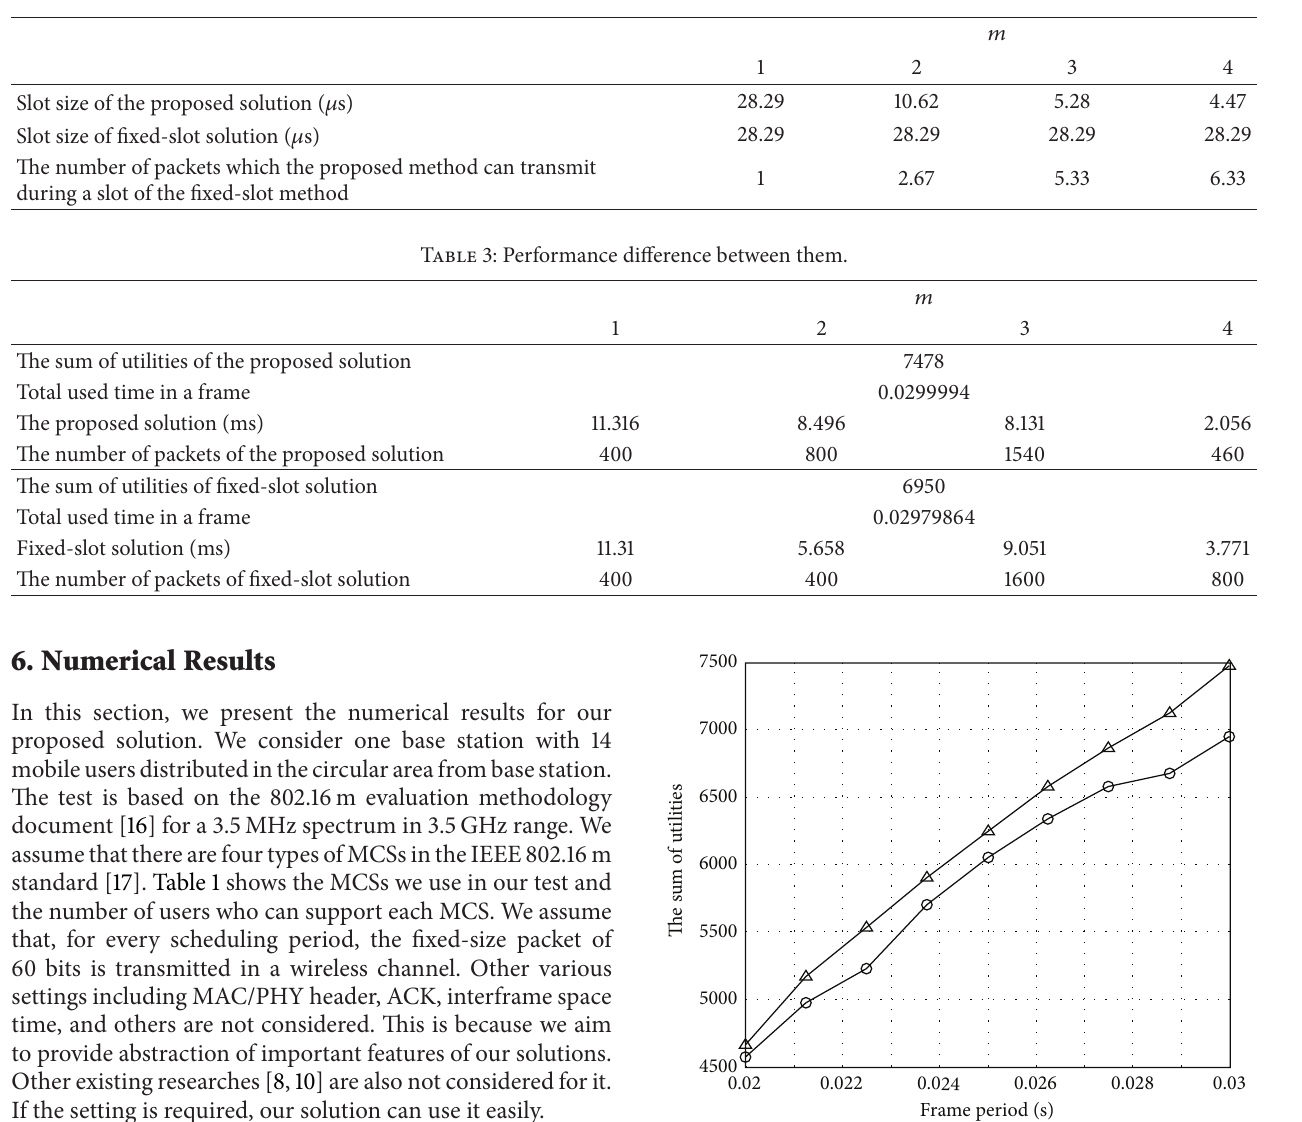
Table 2: Slot size of used solution and the comparison of packet number between them.